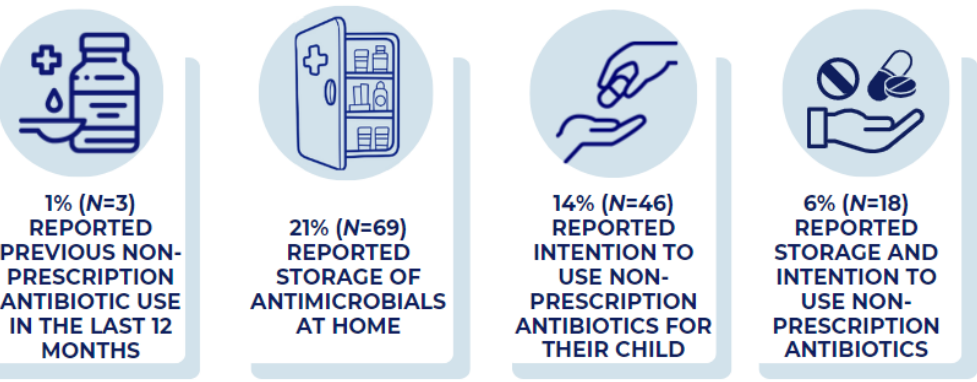
Figure 1. Prevalence of reported prior use, storage of antimicrobials, and intended use of antibiotics. Percentages represent participants who reported previous use of non-prescription antibiotics, storing antimicrobials at home, and intending to use non-prescription antibiotics for their child. See Methods for detailed definitions.